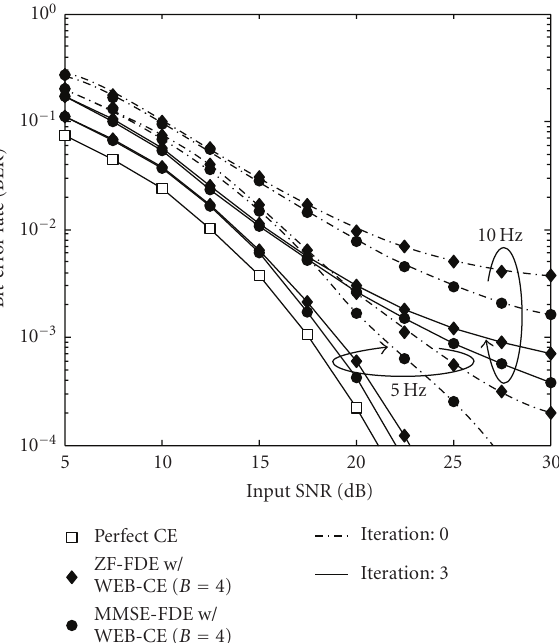
Figure 6: BER performance of ZF-FDE with the WEB-CE ( B = 1)/approx. RLS-CE, and WEB-CE ( B = 2,4) when f d = 10 Hz.